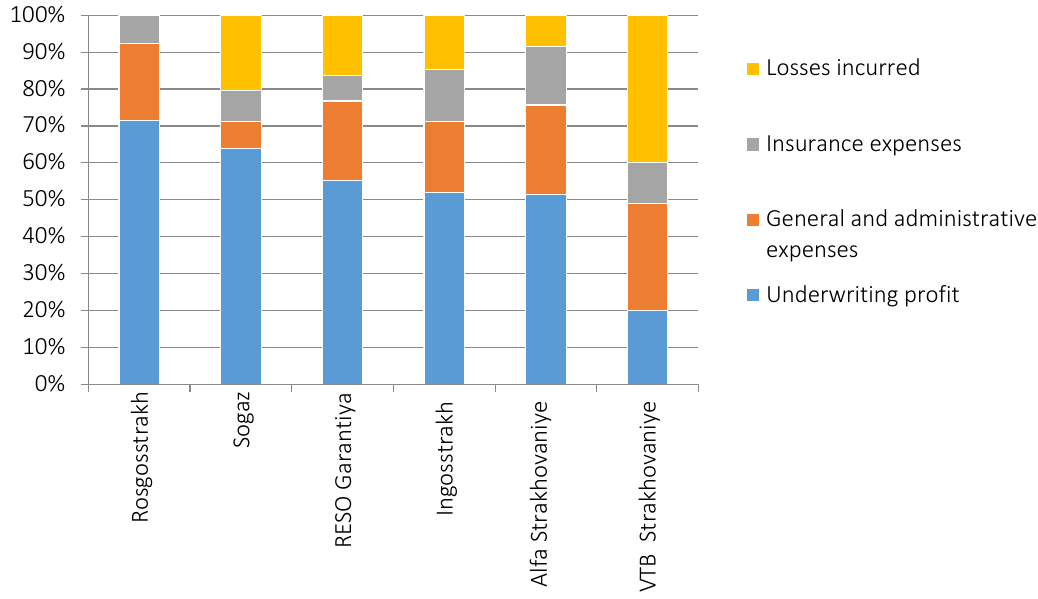
Figure 2. The structure of insurers’ expenses and financial results of insurance activities in